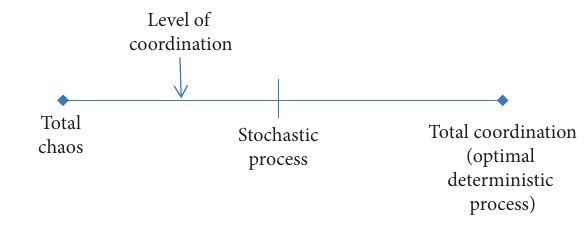
Figure 10: Scale of